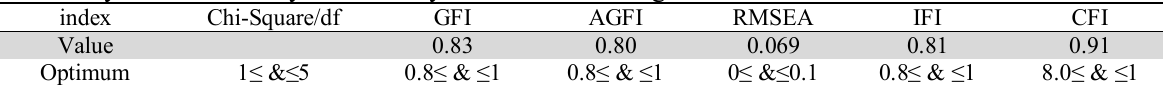
Summary of confirmatory factor analysis and indexes of goodness of